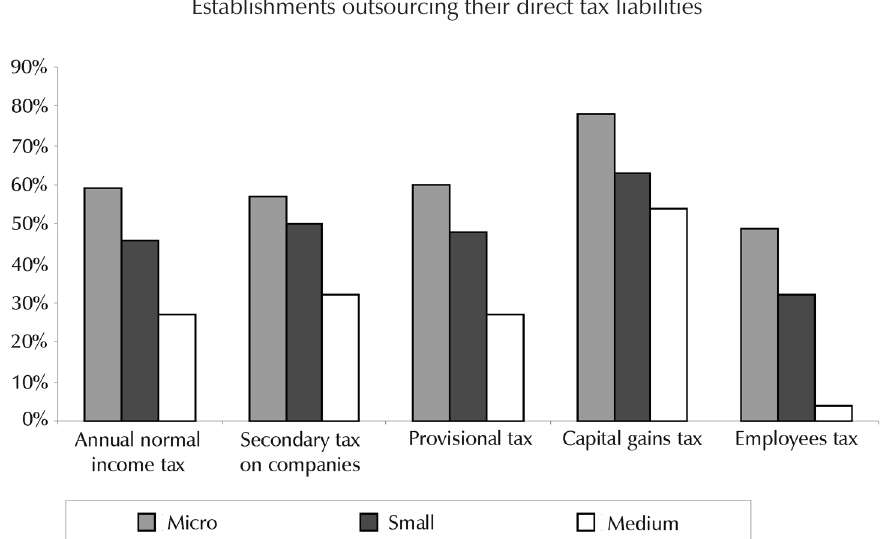
Establishments outsourcing their direct tax